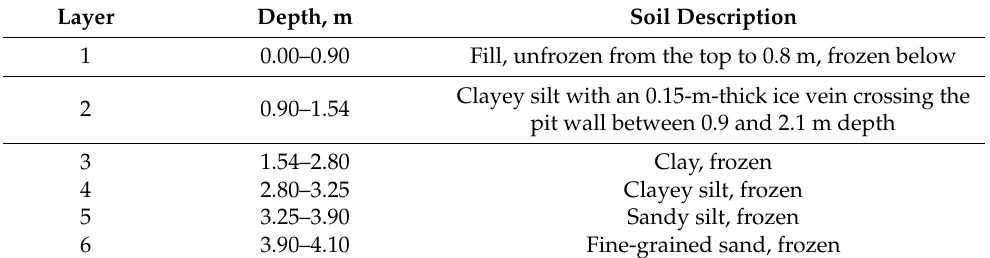
Table 6. Test pit #3.